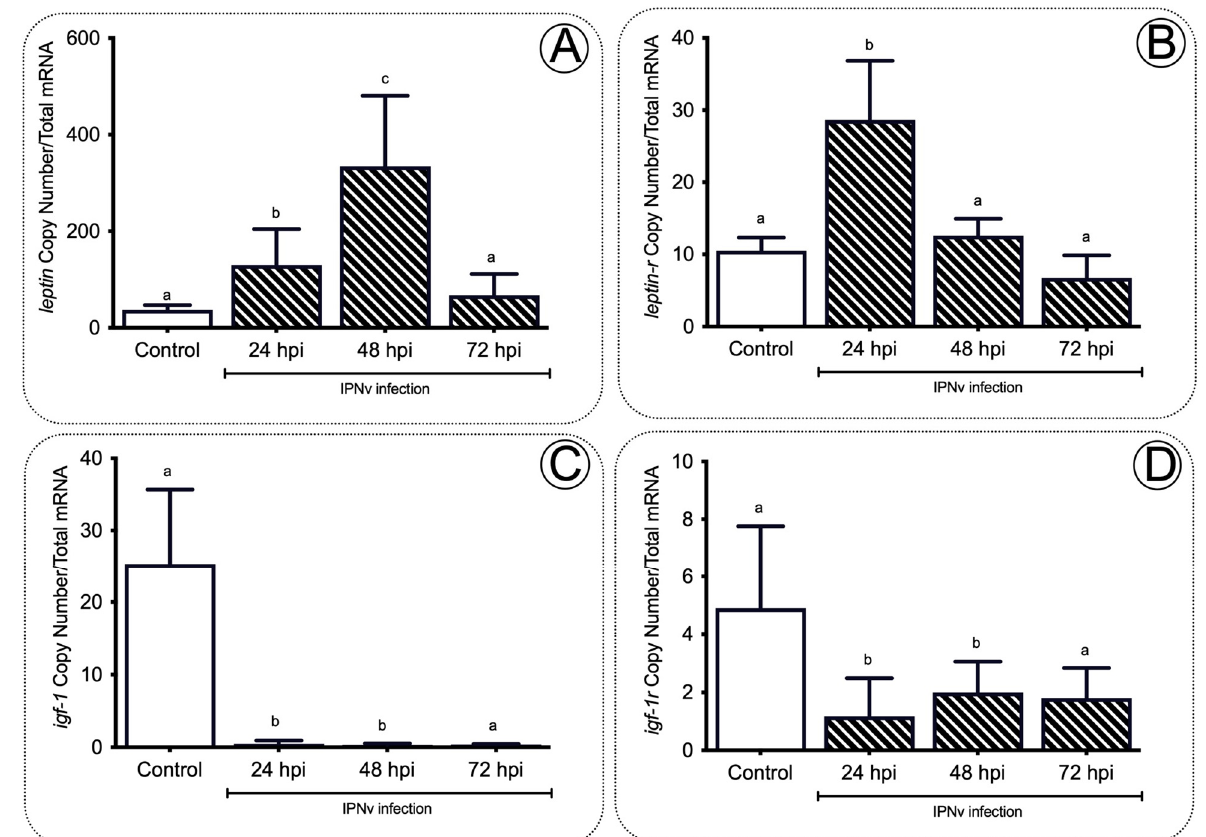
Figure 5. Leptin and insulin expression profiles in the liver of salmon during infection. The leptin ( A ), lepr ( B ), igf-1 ( C ), and igf-1r ( D ) gene expression after IPNv infection on salmon liver tissue. Control sample corresponds to unchallenged fish. Data represent the mean ± SEM. One-way ANOVA; p < 0.05 was considered statistically significant. Different letters denote significant differences.